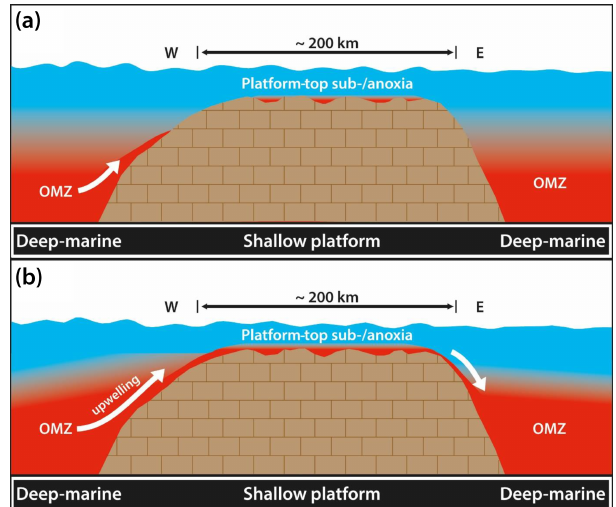
Figure 8. Two models for the transient establishment of oxygen- deficient water masses on the lower Aptian Adriatic